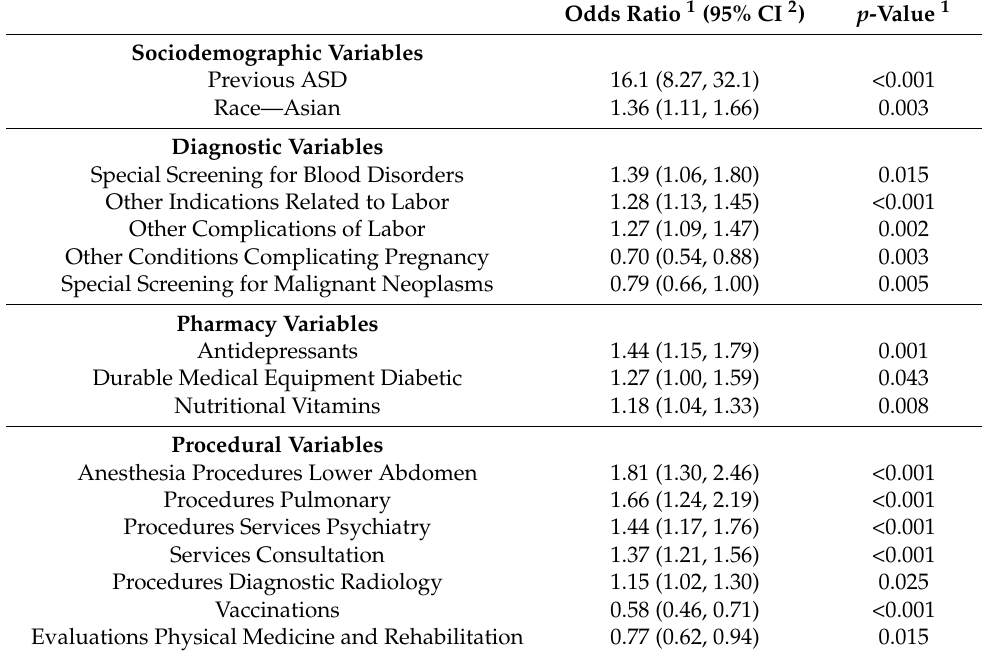
Table 7. Logistic Regression Analysis Results of Variables Identified as Highly Significant during the Entire